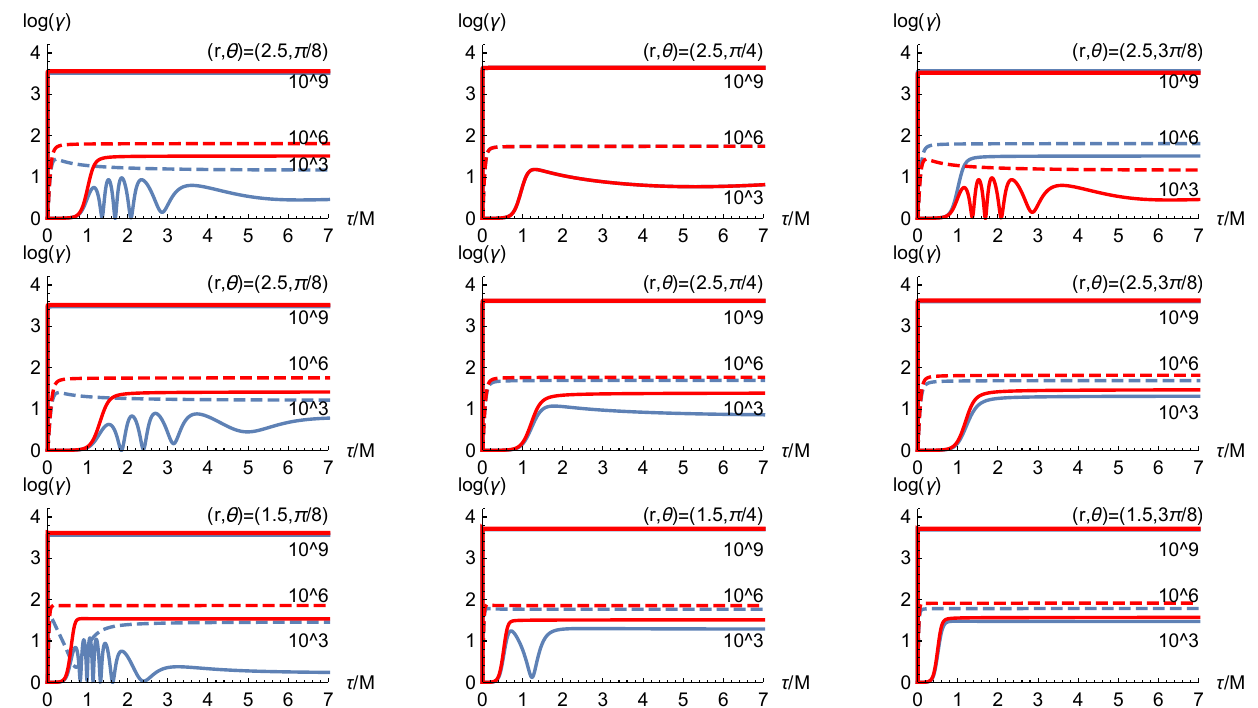
( γ ) as a function of proper time τ . Results are shown for the initial radius r Figure 3. Lorentz factor log 10 black hole ( top panels ), for r 0 = 2.5 M in a Kerr with a = 0.99 M ( middle panels ) and for r 0 = 1.5 M and a = 0.9 M ( bottom panels ). Blue curves are for positive κ , whereas red curves denote negative κ